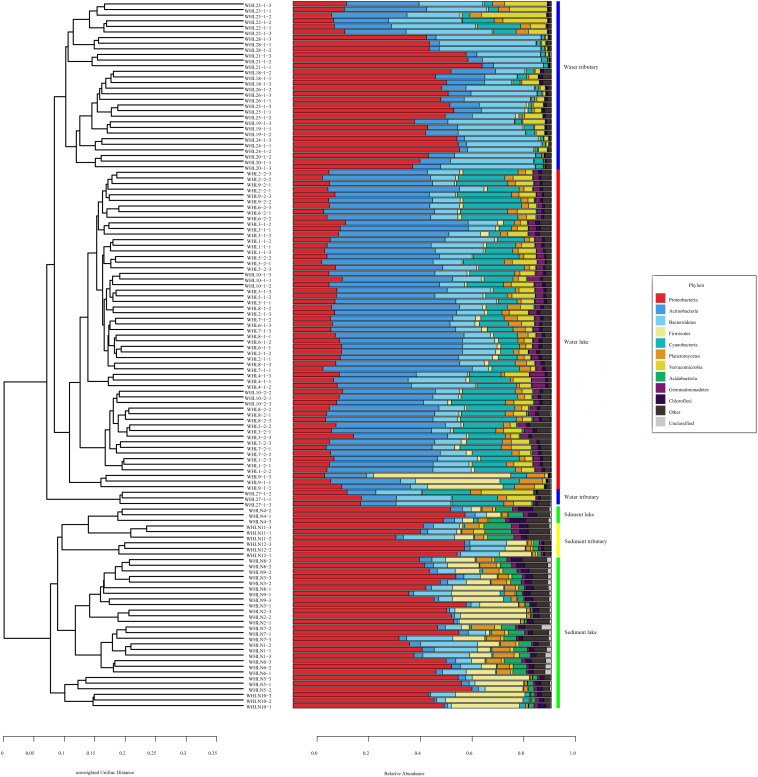
Unweighted pair group method with arithmetic mean (UPGMA) classification trees based on unweighted UniFrac at the phylum level (top 10). The colored vertical lines on the right of the bar chart indicate different sample types.